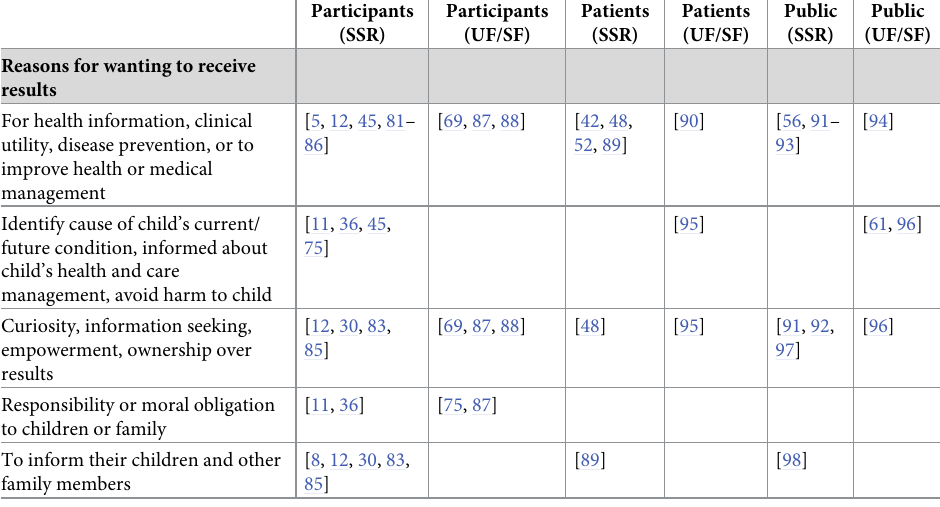
Table 5. Summary of reasons for wanting and not wanting to receive SSR and